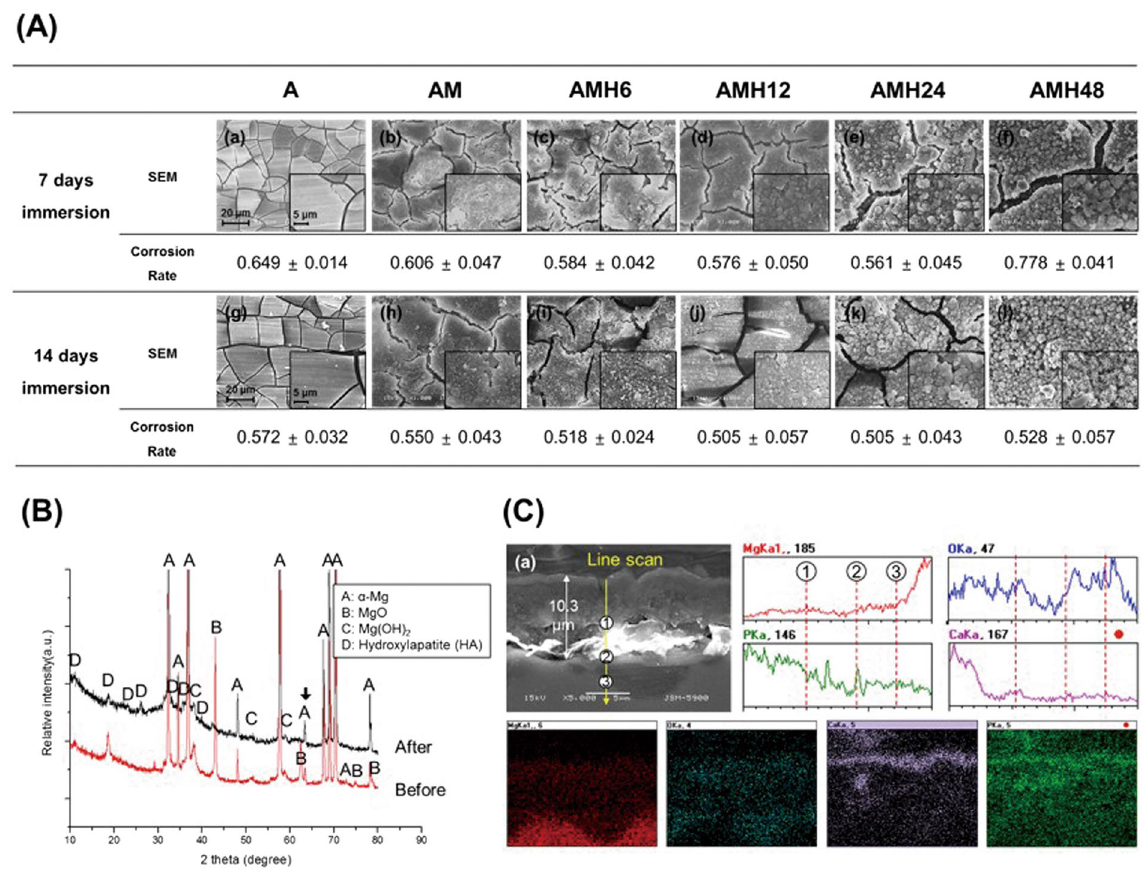
Figure 4. ( A ) SEM images showing surface morphologies of the A, AM, AMH6, AMH12, AMH24 and AMH48 treated surfaces; ( B ) XRD patterns on the surface of the AMH24 group before and after 14 days of immersion in HBSS; ( C ) EDS-line and -mapping analysis on the cross section of the AMH24 group after 3 days of immersion in